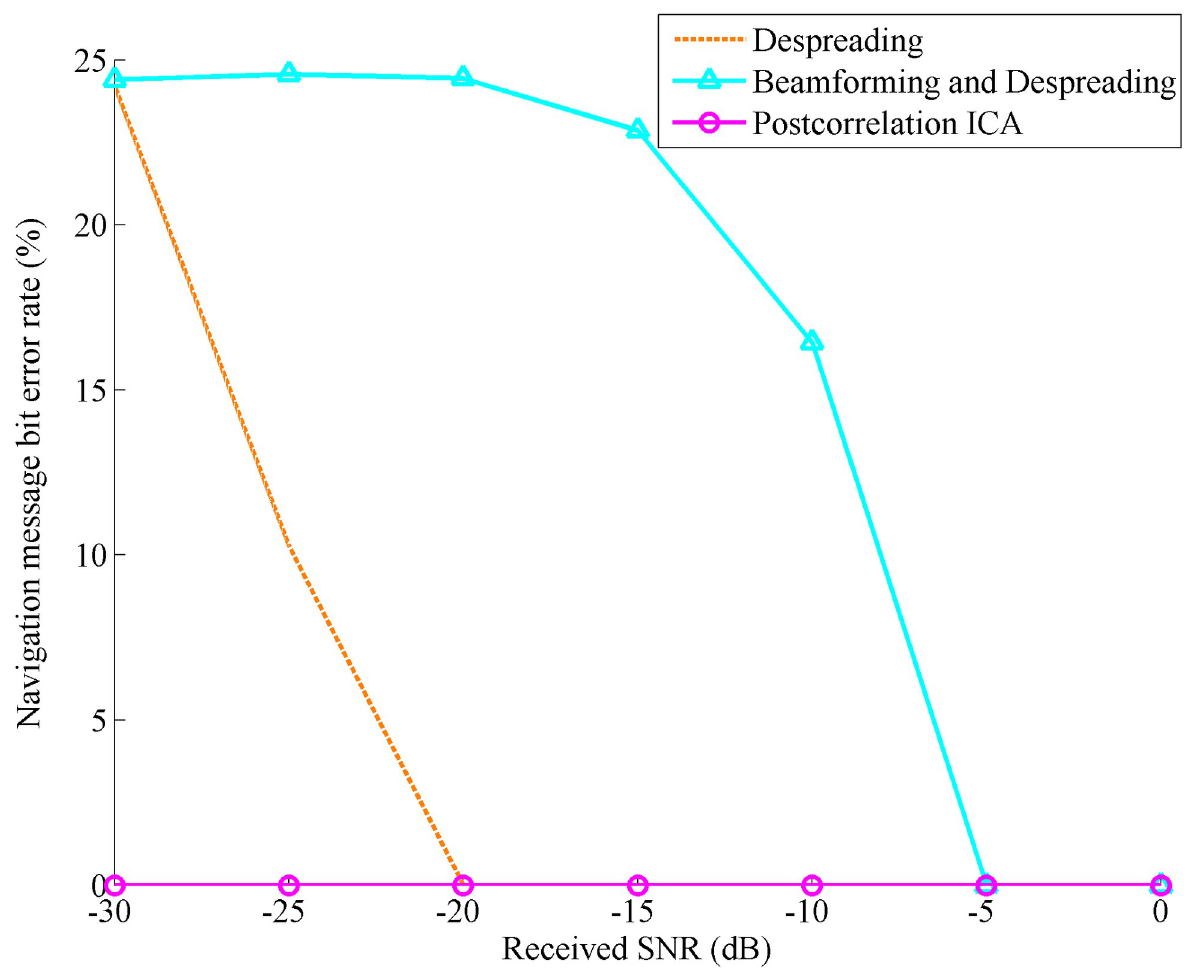
Fig 8. Bit error rate comparison of the navigation message with the received SNR changing after despreading, beamforming and despreading, and postcorrelation ICA processing.